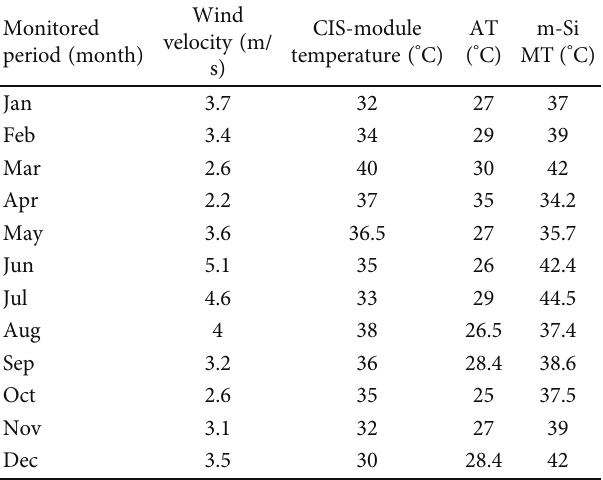
Table 6: Variations in module temperature, wind velocity, and ambient temperature.